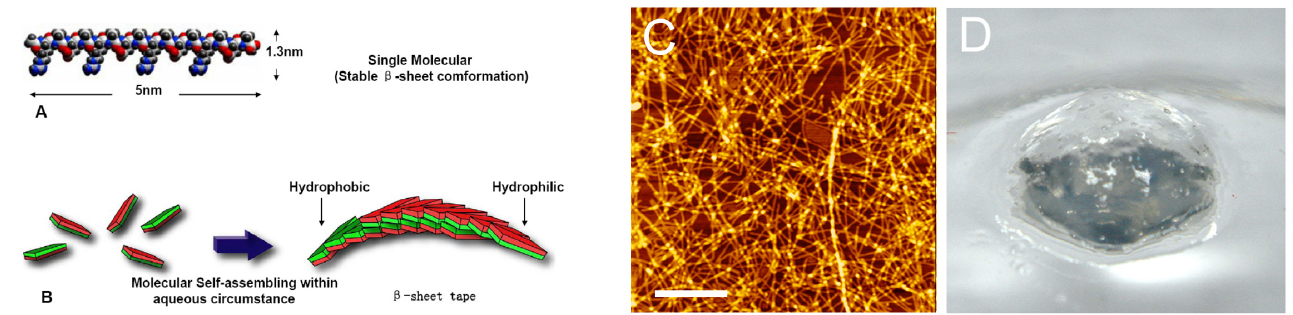
( D ) RADA16-1 gelatinized into